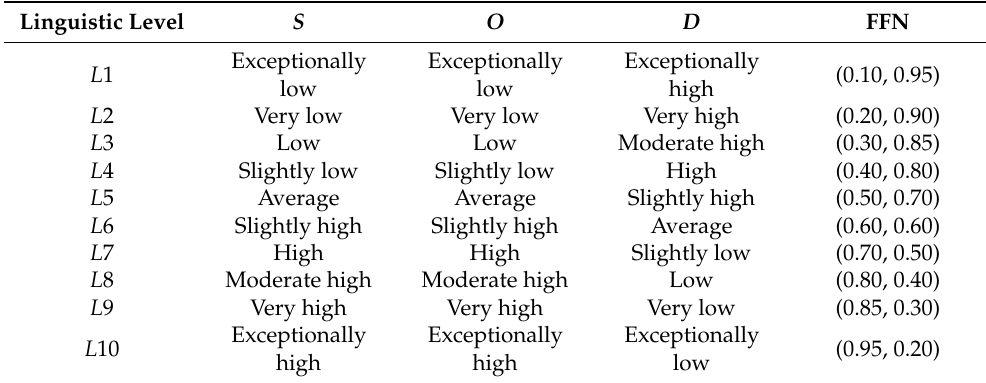
Exceptionally high